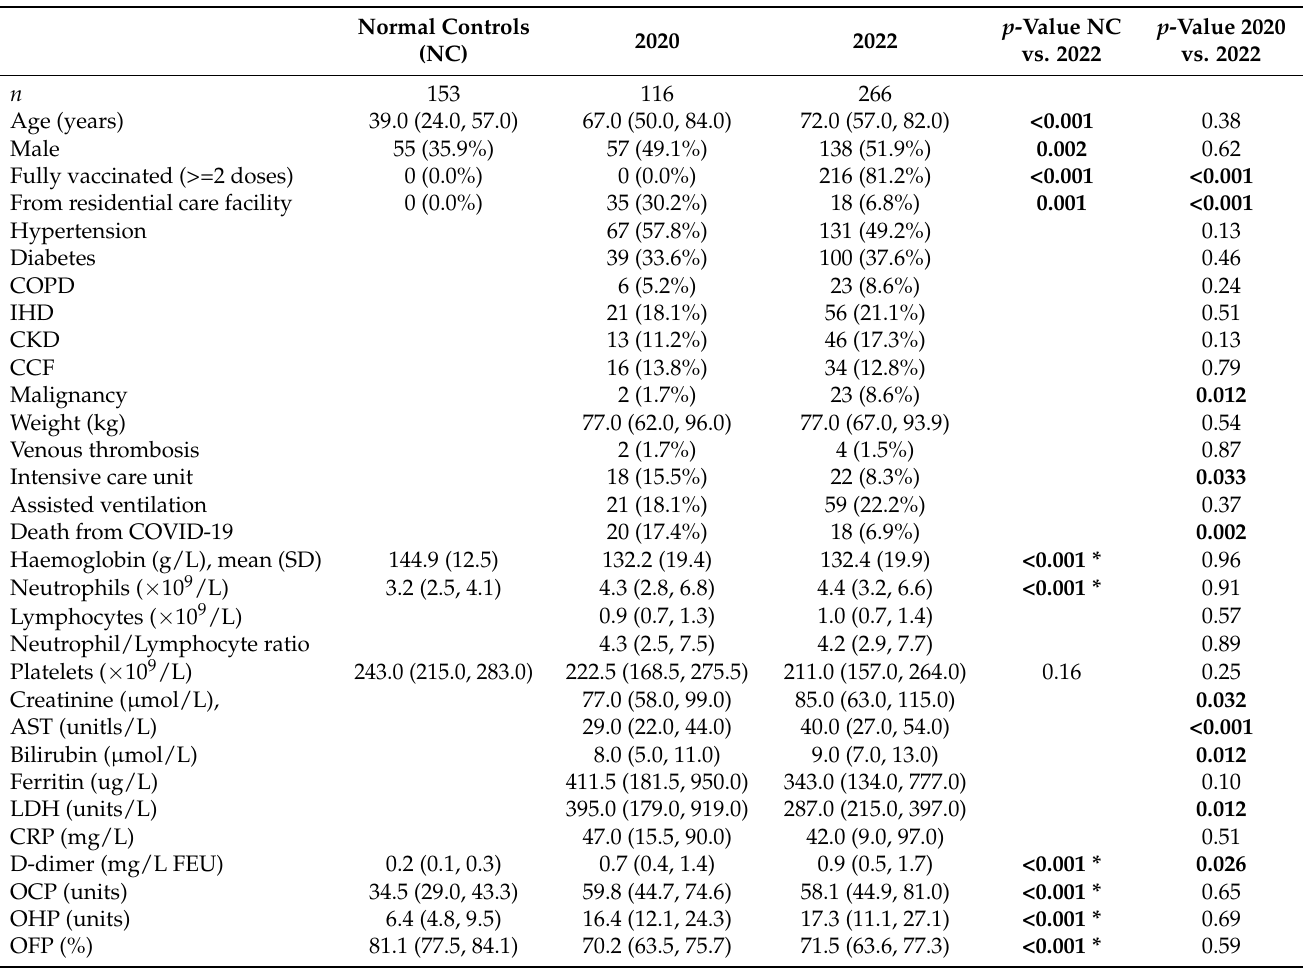
Table 1. Baseline characteristics, laboratory results and clinical outcomes of normal controls compared with COVID-19 patients from 2020 and 2022. Data are n (%), and median (interquartile range, IQR), unless specified otherwise. Normal Controls